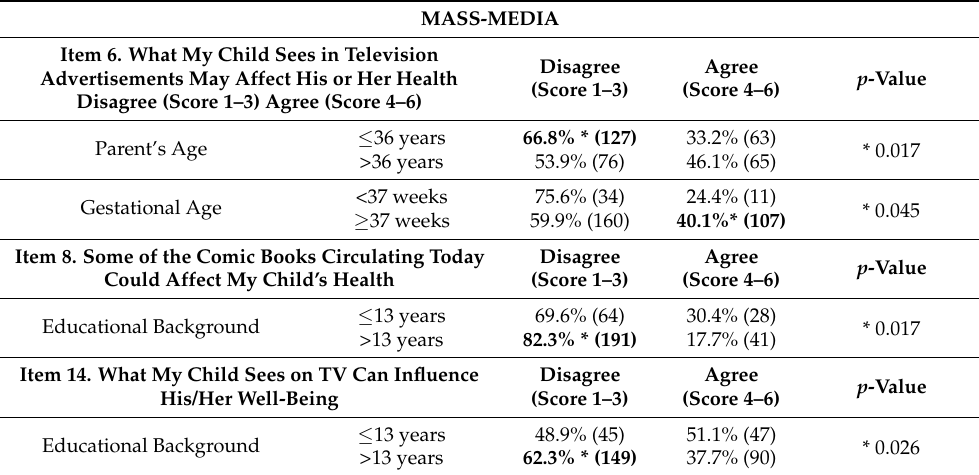
Table 2. Statistically significant correlations between “mass media” category and socio-demographic characteristics.